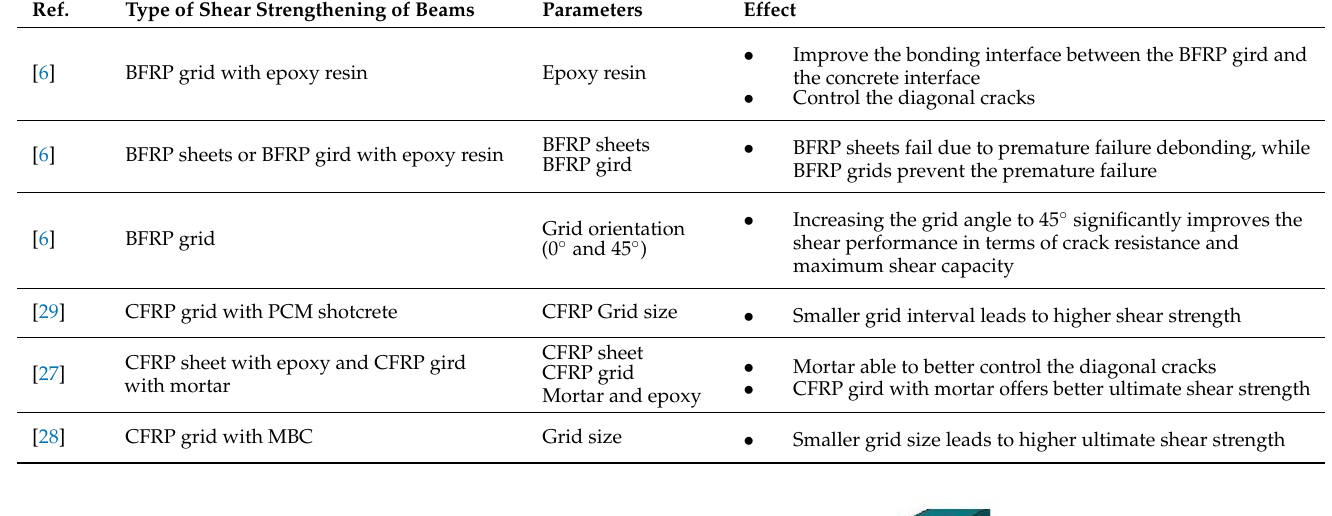
Table 1. General parameters and their effects using FRP materials for the shear strengthening RC beams.